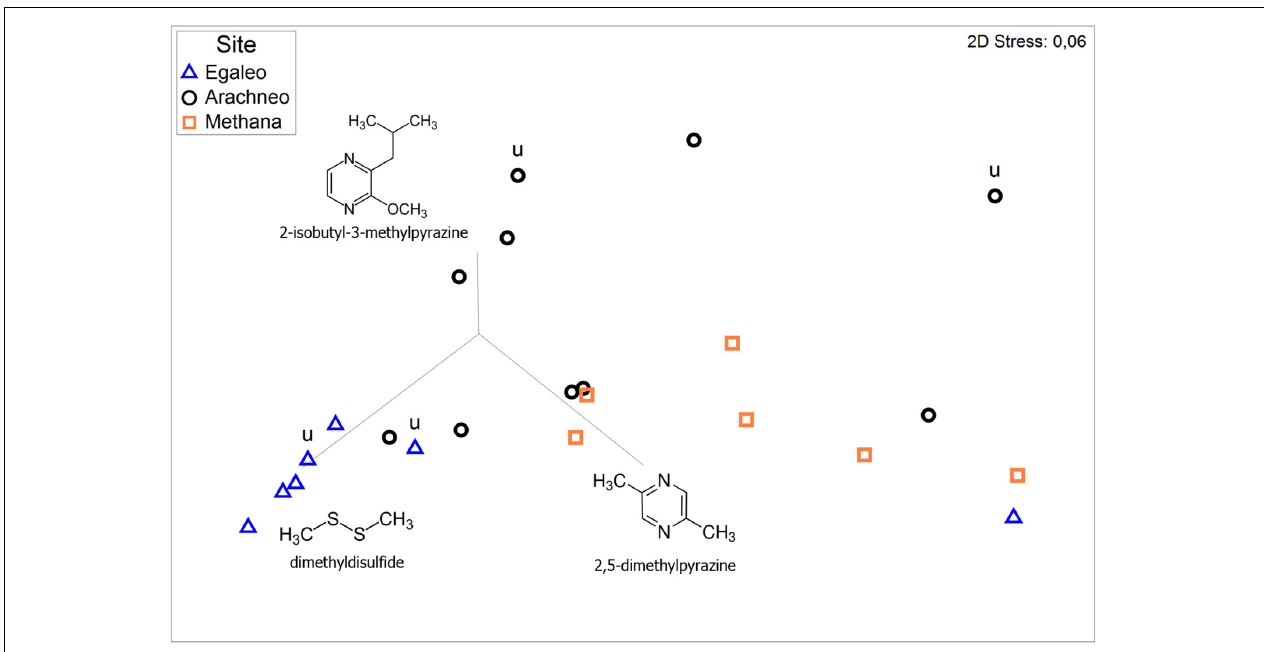
FIGURE 2 | Non-metric multidimensional scaling (NMDS) to visualize semi-quantitative dissimilarities among individual floral scent samples from three Aristolochia microstoma populations in Greece: Egaleo ( n = 7); Arachneo ( n = 10); and Methana ( n = 6). The ordination is based on pairwise Bray-Curtis similarities. The vectors depict the volatiles most correlating with the axes. “u” marks samples collected from uncut flowers, all other samples were collected from cut flowers.